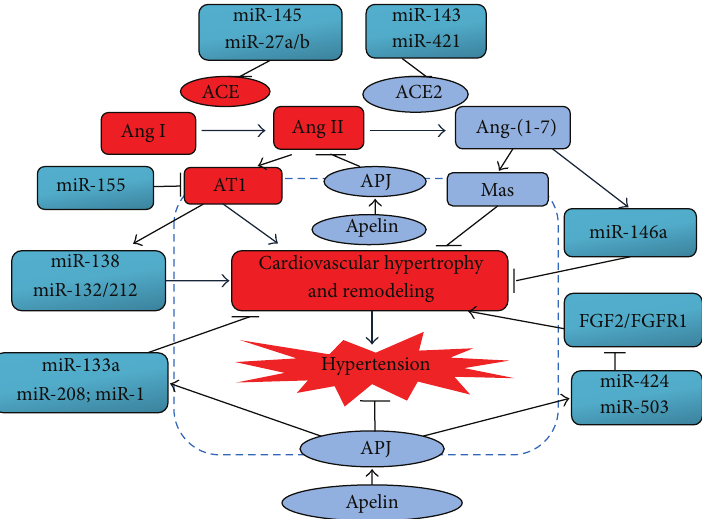
Figure 1: The crosstalk between ACE2/Apelin signaling and miRNAs in hypertension. On one hand, the miR-145 and miR-27a/b suppress the action of ACE/Ang II/AT1R, whereas miR-143 and miR-421 serve as negative regulators of ACE2 to modulate the balance between Ang II degradation and Ang-(1-7) generation. Overexpression of miR-155 inhibits the effects mediated by Ang II/AT1R signaling while Ang II regulates miR-138 and miR-132/212 expression via its receptor AT1R, contributing to cardiovascular hypertrophy and remodeling and elevated blood pressure. In contrast, Ang-(1-7) promotes the level of miR-146a, which blocks inflammation and cardiovascular remodeling. On the other hand, the Apelin/APJ signaling regulates the expression of miR-133a, miR-208, and miR-1, functioning as negative regulators for cardiac hypertrophy and contractile function. Moreover, the Apelin/APJ ameliorates cardiovascular hypertrophy and remodeling by modulating miR-424/-503-FGF signaling. ACE: angiotensin converting enzyme; ACE2: angiotensin converting enzyme 2; Ang II: angiotensin; AT1R: angiotensin II type 1 receptor; miRNAs: microRNAs; FGF2: fibroblast growth factor 2; FGFR1: fibroblast growth factor receptor